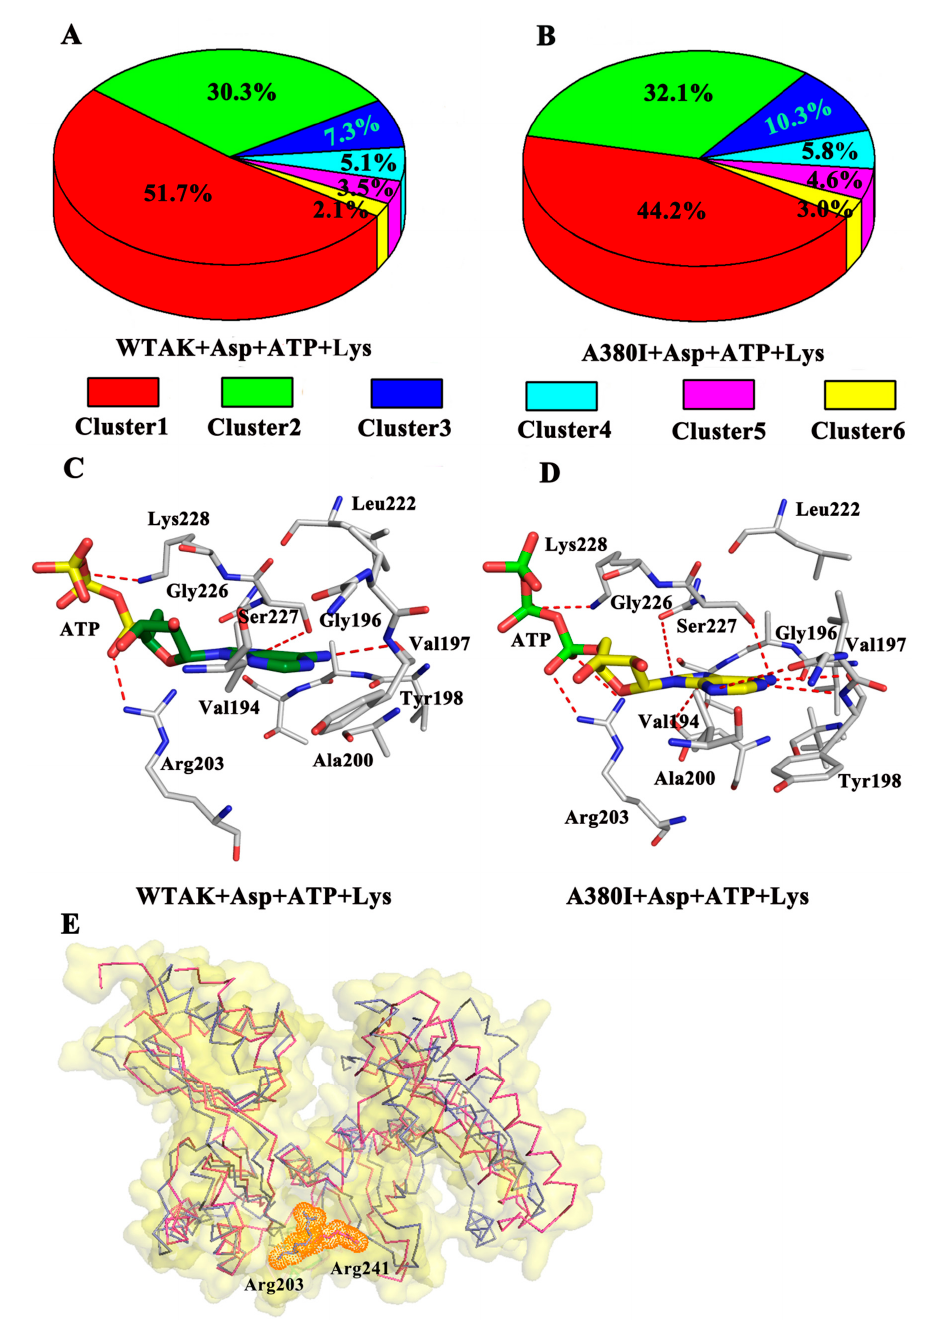
Figure 7. ( A ) Cluster analysis of WT-AK with Asp, ATP and Lys complex. ( B ) Cluster analysis of A380I mutant with Asp, ATP and Lys complex. ( C ) Hydrogen bond network between ATP and WT-AK. ( D ) Hydrogen bond network between ATP and A380I. The red dotted lines in C and D represent hydrogen bonds. ( E ) the pink ribbons represent mjAK and the slate ribbons represent CpAK; slate and pink stick represent residues Arg203 and Arg241 in orange